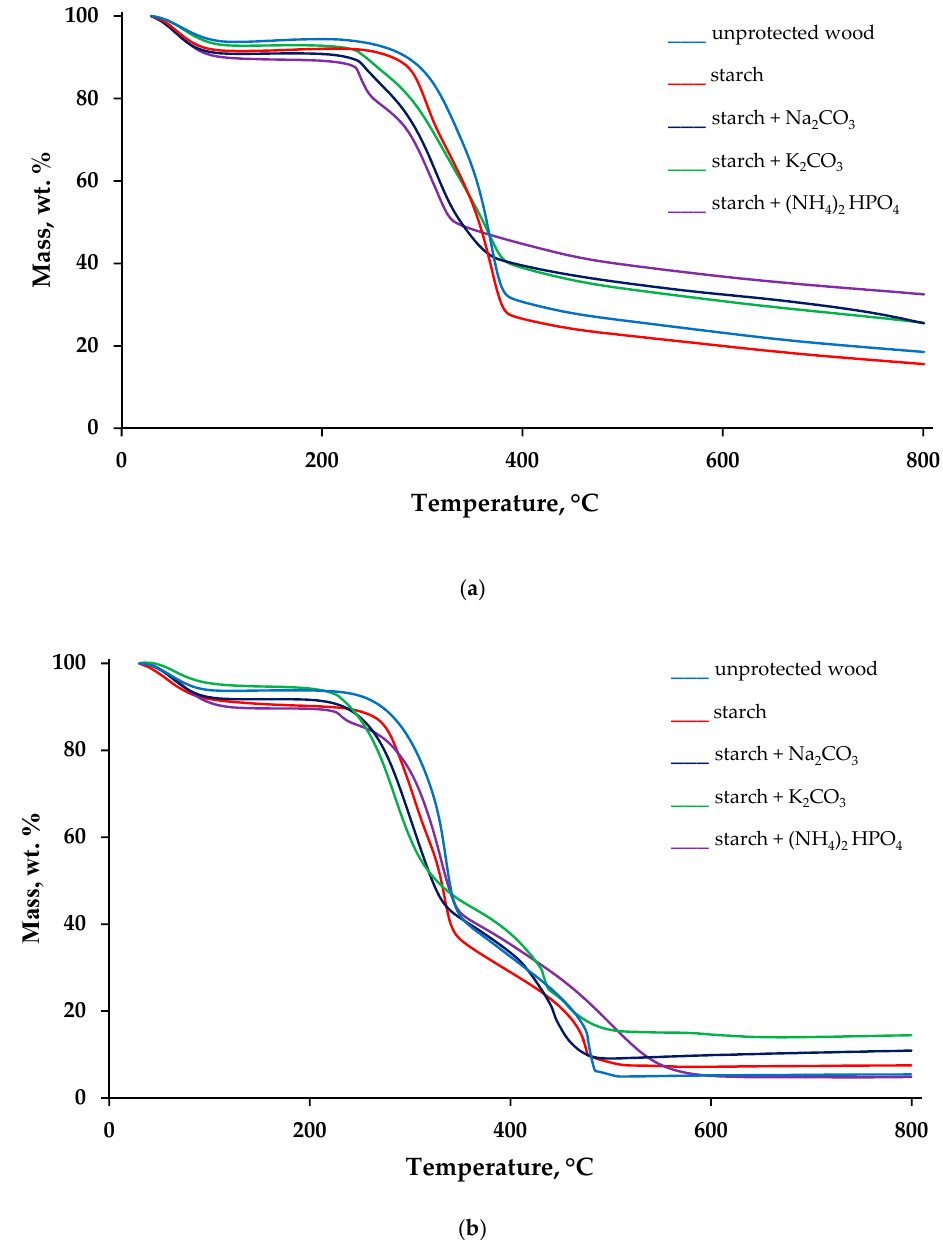
Figure 2. TG traces recorded on the samples of unprotected wood and wood protected with starch ‐ based formulations, under nitrogen ( a ) and air ( b ).